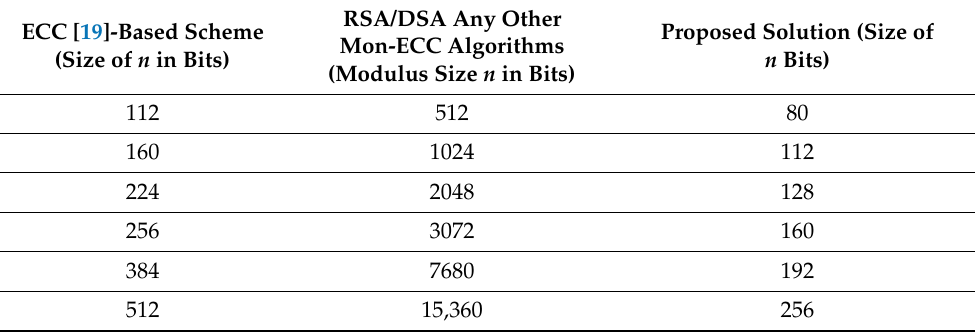
Table 1. Comparison of ECC and Non-ECC